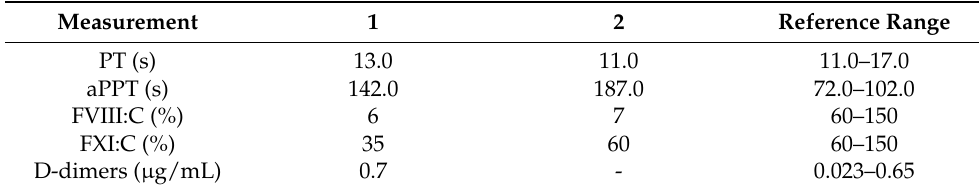
Table 1. Coagulation assay